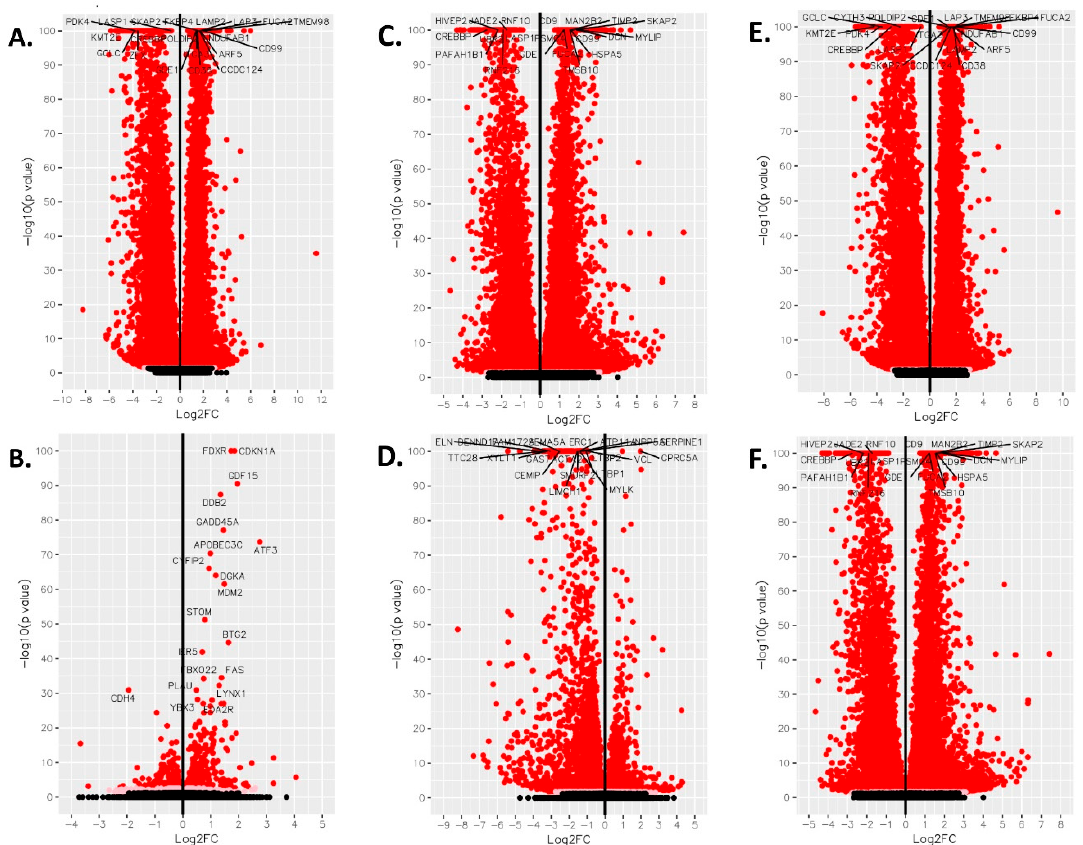
Figure 4. Volcano plot analysis of phenanthriplatin and cisplatin modulation of cellular pathways in A549, IMR90, and between A549 and IMR90 cells. Volcano plot for ( A ) A549 phenanthriplatin vs. A549 control, ( B ) A549 cisplatin vs. A549 control, ( C ) IMR90 phenanthriplatin vs. IMR90 control, ( D ) IMR90 cisplatin vs. IMR90 control, ( E ) A549 phenanthriplatin versus A549 cisplatin, and ( F ) IMR90 phenanthriplatin versus IMR90 cisplatin treatments. Log2 fold change on the x-axis is plotted against –log10( p -value) on the y-axis. Key: filled black circle = not significant, filled pink circle = p value < 0.05, filled red circle = q value < 0.05.